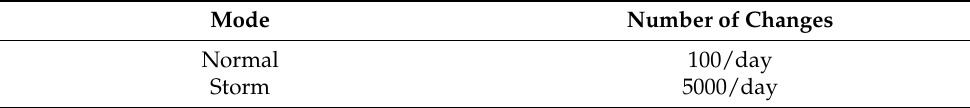
Table 3. Simulator’s